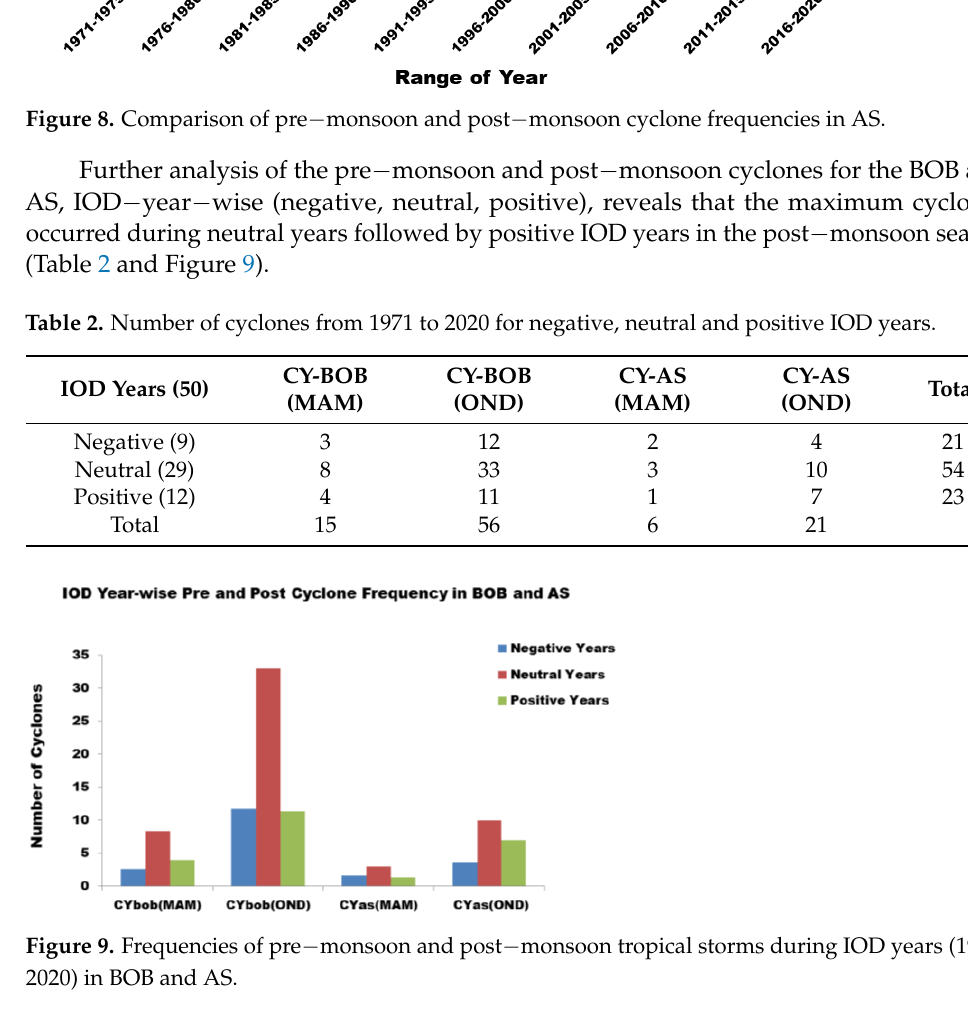
Figure 8. Comparison of pre − monsoon and post − monsoon cyclone frequencies in AS.